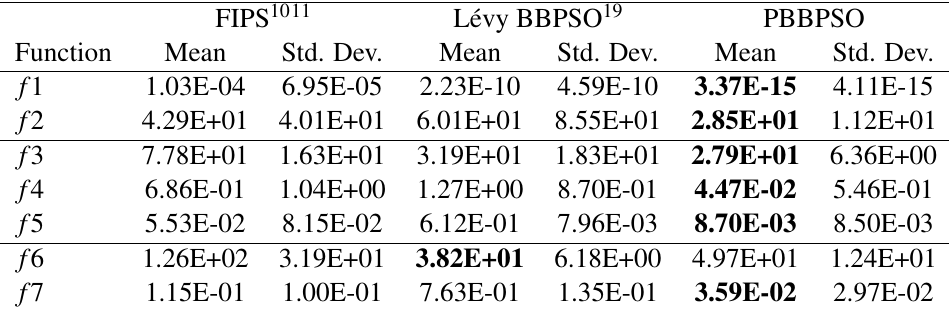
Table 3: Comparisons of empirical error between FIPS, L´evy BBPSO, PBBPSO FIPS 1011 L´evy BBPSO 19 PBBPSO Function